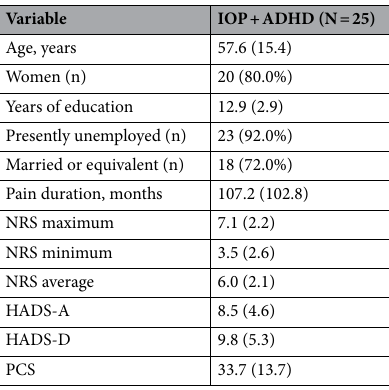
Table 1. Patient characteristics. ADHD attention-deficit/hyperactivity disorder, HADS-A/D Hospital Anxiety and Depression Scale-subscale for anxiety/depression, IOP idiopathic orofacial pain, NRS Numerical Rating Scale, PCS Pain Catastrophizing